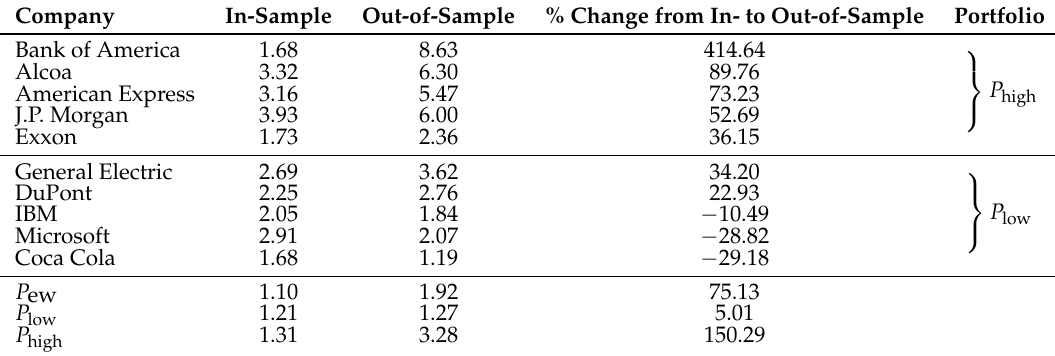
Table 2. Average realized daily variances of assets and